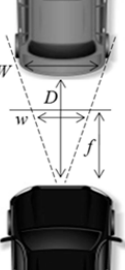
Figure 9. Distance estimation.